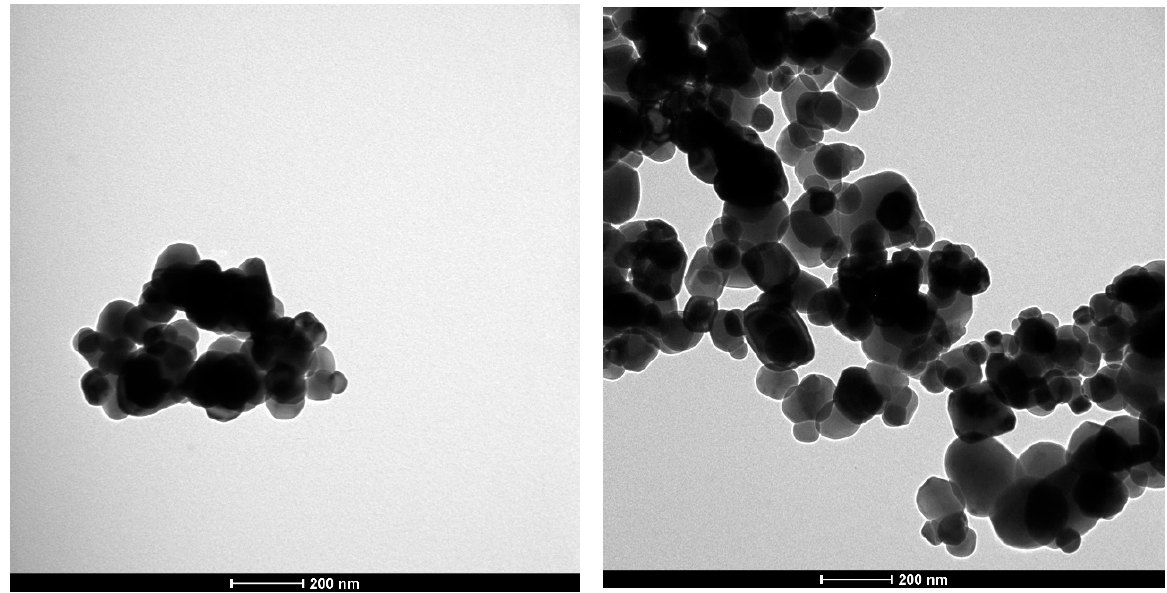
Figure 1. Exemplary transmission electron microscopy (TEM) images of food grade E 171 in sterile water (60,000 × magnification).